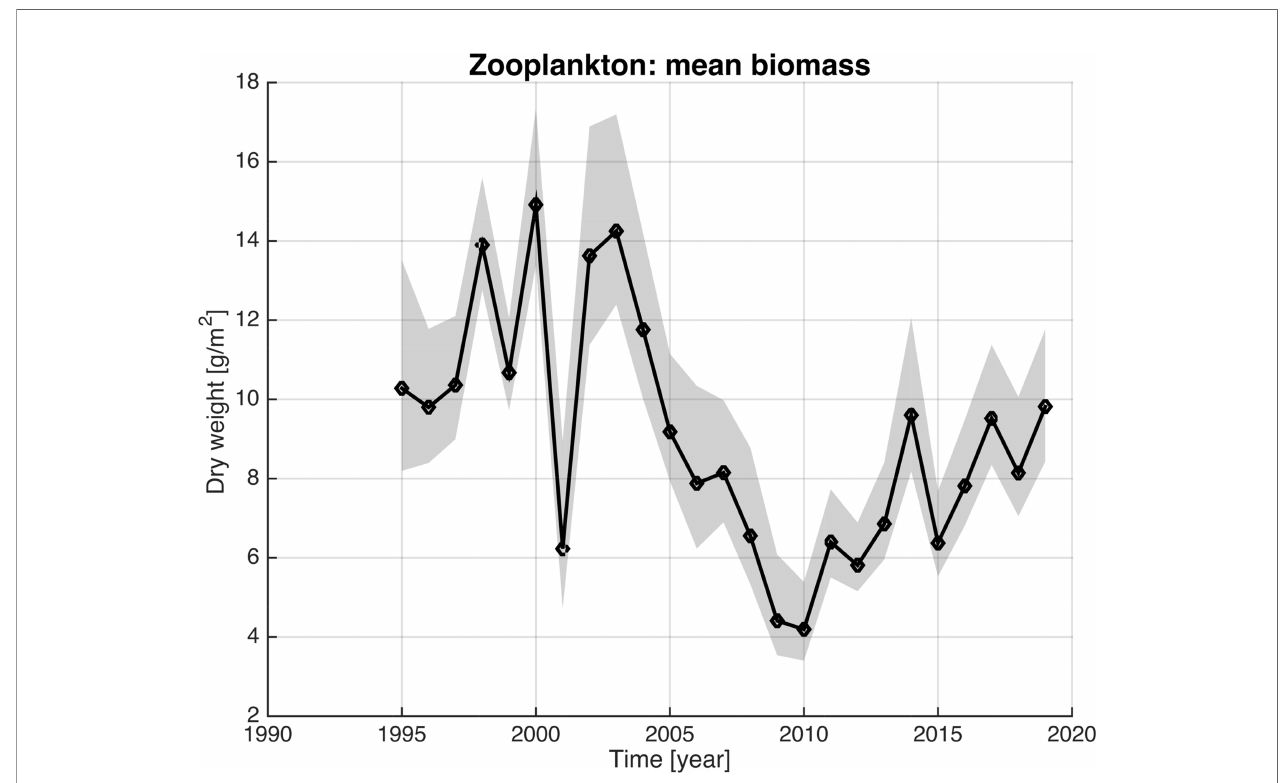
FIGURE 8 | Median zooplankton biomass in the Norwegian Basin in May. The mean number of observations per year is 93. Solid line shows the median and the gray band represents the 95% con fi dence